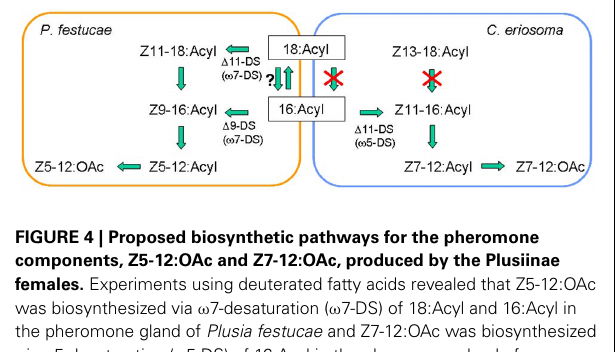
thus, the pheromones are produced by a combination of one